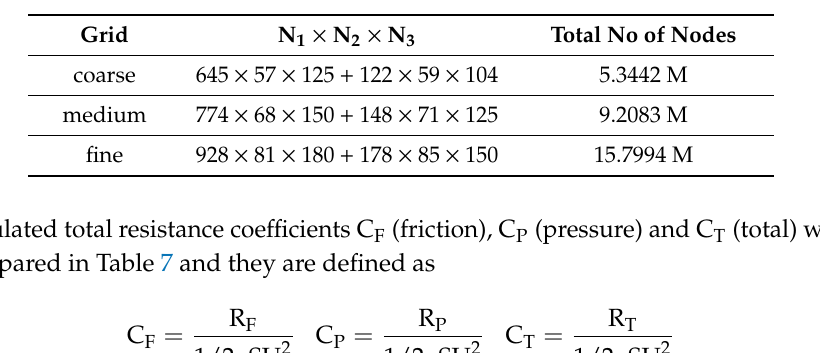
Figure 22. Water elevation around the bow ( a ) and the stern ( b ), model scale, Fn = 0.180. Table 6. Characteristics of the used